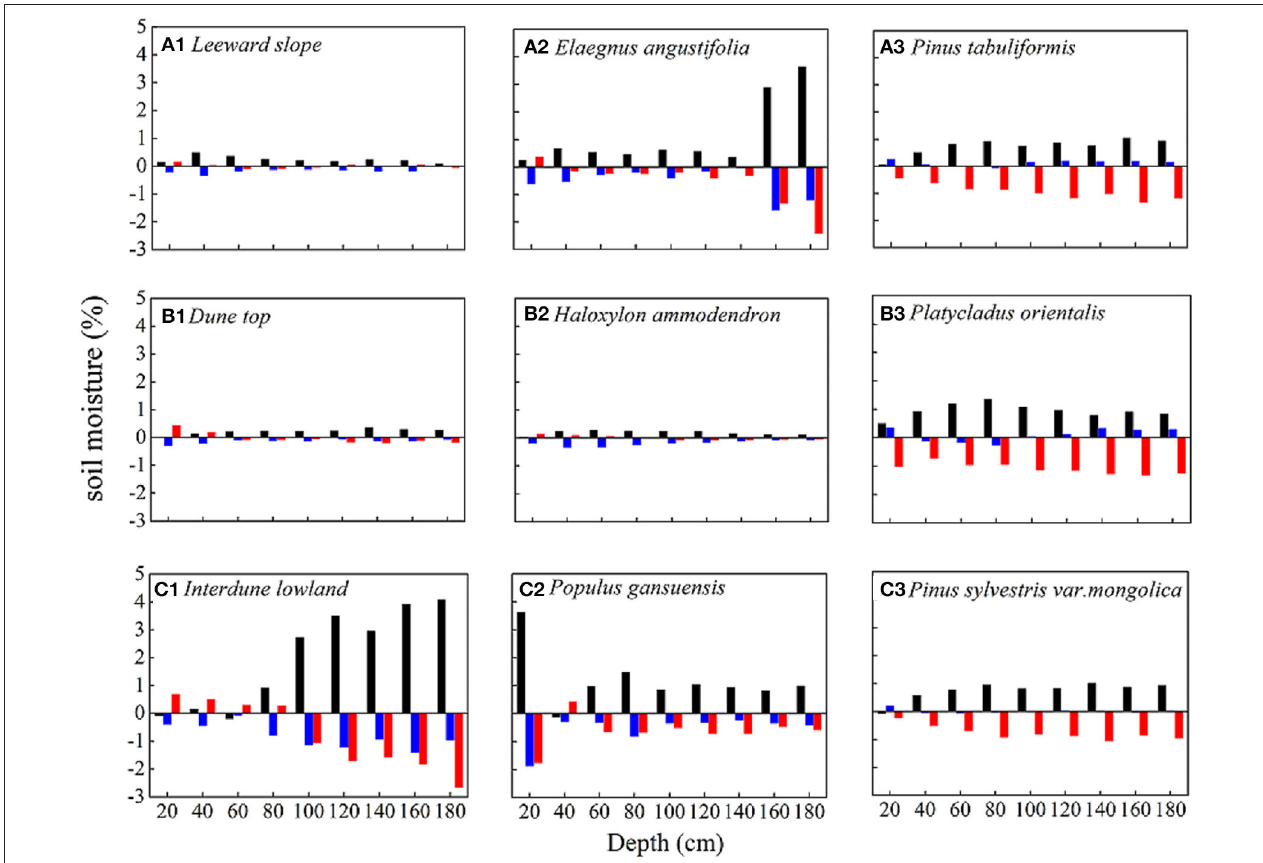
FIGURE 4 | The anomalies of soil water content in desert (A1, B1, and C1) , shrubland (A2, B2, and C2) , and woodland (A3, B3, and C3) . Black represents early period (April–May), blue represents middle period (June–August), and red represents late period